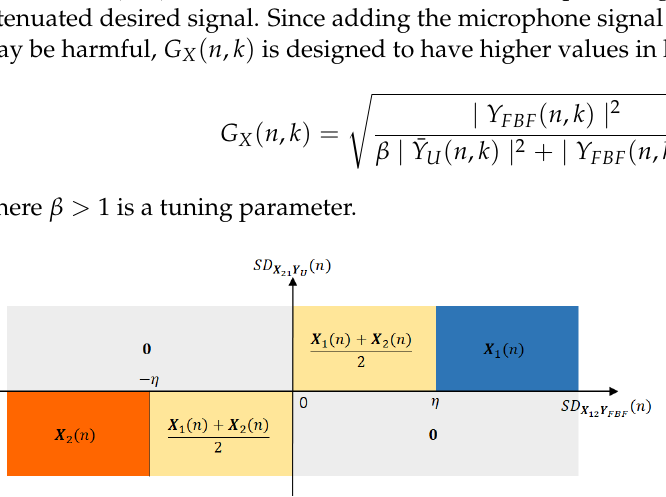
Figure 2. Selected microphone signal to be used for signal recovery depending on the similarity differences between the microphone signals and the outputs of the FBF and